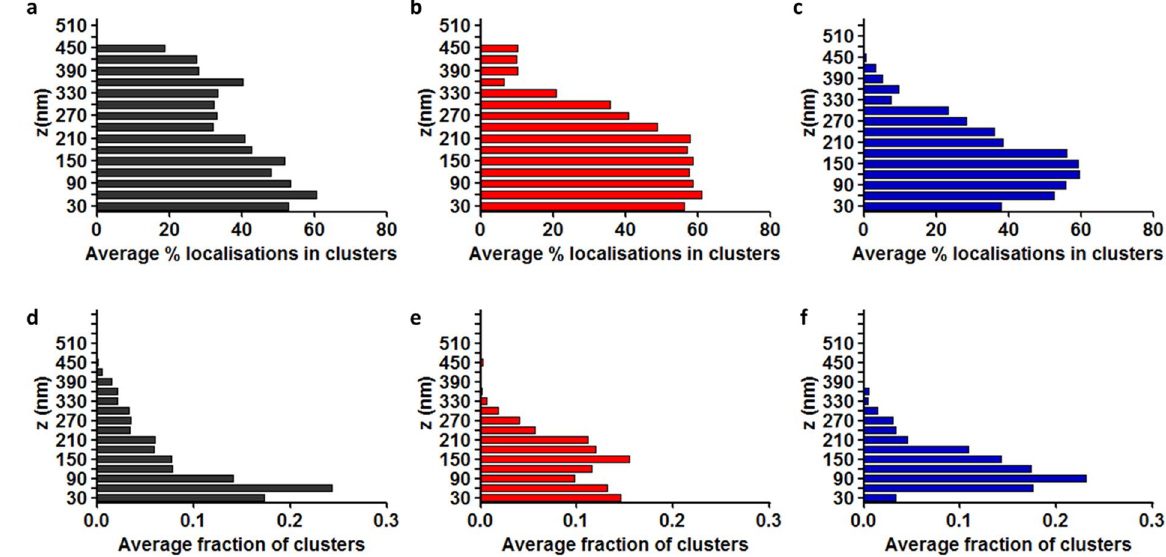
Figure 4. Histograms of the z distribution of LAT at the T cell immunological synapse. ( a ) Average percentage of localisations in clusters at each z plane for the control condition. ( b ) Average percentage of localisations in clusters at each z plane for 4 minutes post-activation. ( c ) Average percentage of localisations in clusters at each z plane for 8 minutes post-activation. ( d ) Average fraction of number of clusters at each z position for the control condition. ( e ) Average fraction of number of clusters at each z position for 4 minutes post-activation. ( f ) Average fraction of number of clusters at each z position for 8 minutes post-activation. Histogram bins are 30